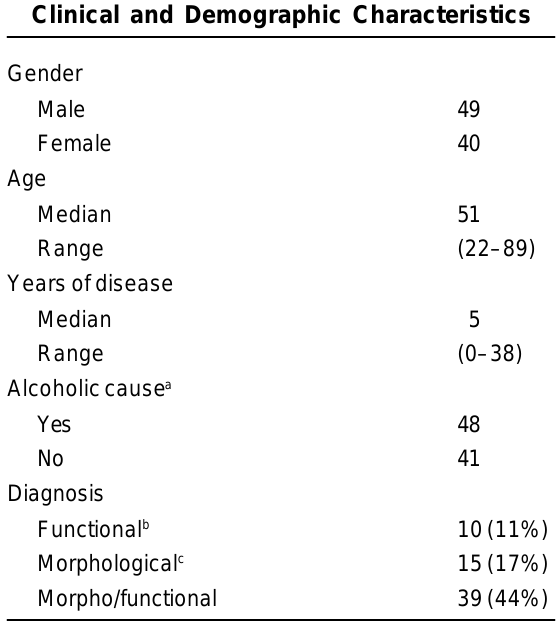
Clinical and Demographic Characteristics